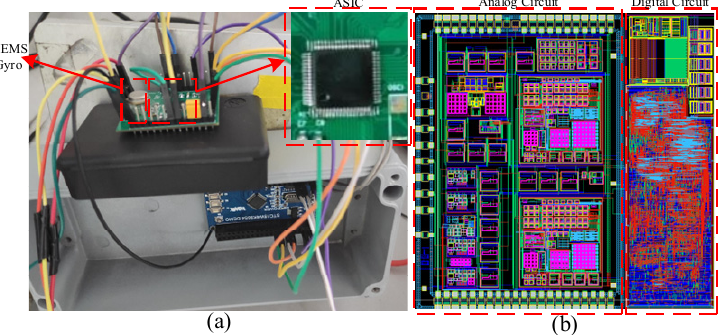
Figure 20. MEMS gyroscope test circuit platform diagram: ( a ) MEMS gyroscope test circuit; ( b ) MEMS gyroscope ASIC layout.